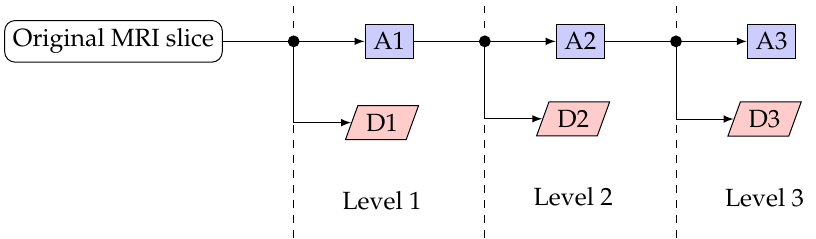
Figure 3. DWT analysis block diagram. DX indicates the detailed image at level X and AX indicates the approximated image at level